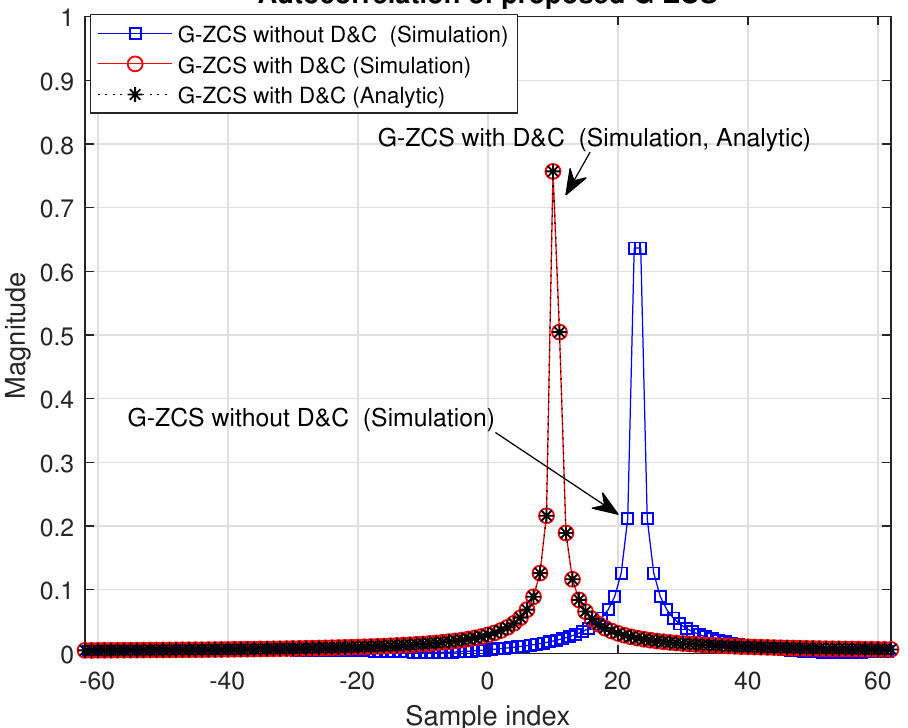
Figure 4. Autocorrelation result of the proposed G-ZCS ( p c = 2.5, M = 625, ν = 1.5, and δ =